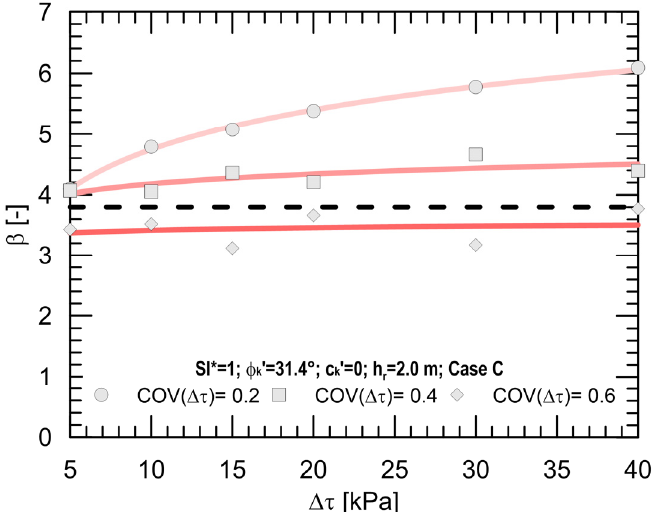
(cid:48) = 31.4 ◦ and seismic case k